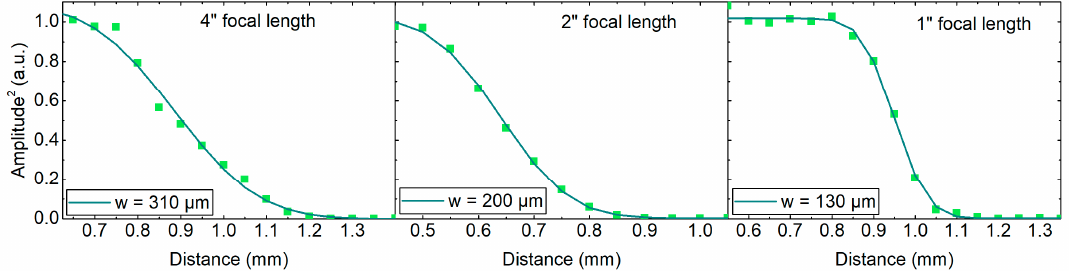
Figure 8. Square of the reflected THz amplitude as a function of distance over an edge of the ceramic sample of Figure 7, top row. The three graphs show the results for the three mirrors with focal lengths of 4”, 2”, and 1”. The data was fitted with the function of Equation (2) and the width of the point spread function w was used as a measure of the lateral resolution. For the 4”, 2”, and 1” focal length mirrors, the extracted values are 310, 200, and 130 µm, respectively.